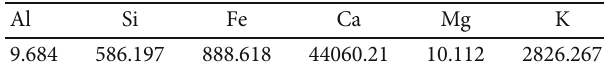
Table 1: Major chemical components of calcium-rich zeolites by